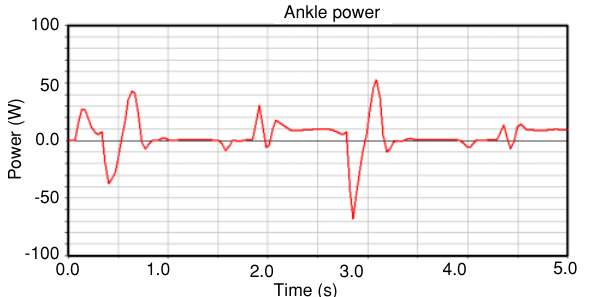
Figure 14 Ankle instantaneous mechanical